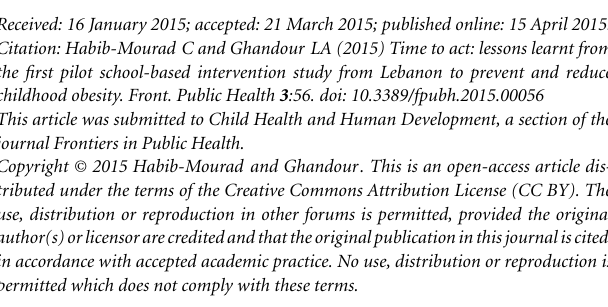
28. SwinburnB,EggerG.Preventivestrategiesagainstweightgainandobesity. Obes Rev (2002) 3 (4):289–301. doi:10.1046/j.1467-789X.2002.00082.x ConflictofInterestStatement: Theauthorsdeclarethattheresearchwasconducted in the absence of any commercial or financial relationships that could be construed as a potential conflict of